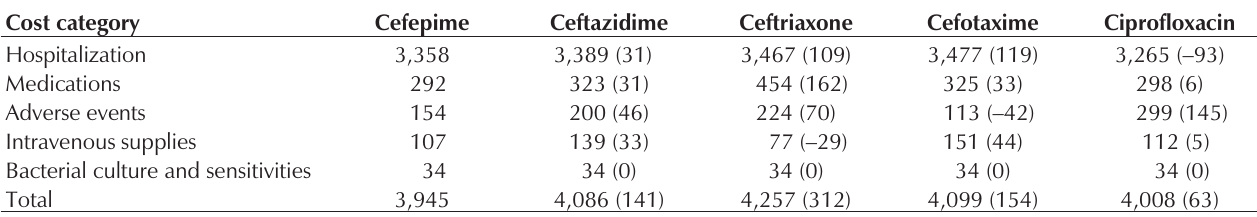
*The five infectious disease conditions were weighted by their relative incidences. Values in parentheses represent marginal costs compared with cefepime